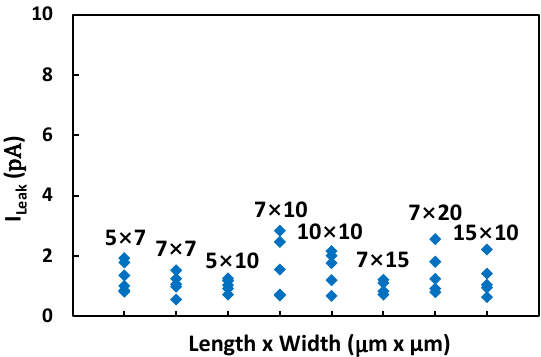
Figure 24. Measurement statistics showing extremely low leakage currents I leak for gNEMS devices under TLP zapping [44].